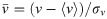
Empirical data for the 2014 and 2018 elections for federal deputies in Brazil, which counted more than 6000 candidates, roughly 140 million voters, and more than 280 million dollars of total investment in each campaign.(A) The standard deviation as a function of the average number of votes per candidate at the state level, for the top four populated Brazilian states, namely, São Paulo (SP, circles), Rio de Janeiro (RJ, squares), Minas Gerais (MG, diamonds), and Bahia (BA, triangles), empty symbols are for 2018, and filled symbols are for 2014. For each state, candidates were grouped by the amount of money that they officially declared to have spent in their campaigns. The dashed line corresponds to a linear behavior. (B) Distribution of rescaled number of votes v¯=(v-〈v〉)/σv for São Paulo (orange circles) and the entire country of Brazil (blue triangles), where 〈v〉 and σv are the average and standard deviation of the number of votes received by the candidates in the same interval (logarithmic binning) of money spent. The black line corresponds to p(v)=exp(-v¯-1), as predicted by Eq (5), if we assume Z(m) = 1/μ. Following the prediction given by Eq (5) from our theoretical approach, the distribution of votes for more than 99% of the candidates follows an exponential distribution. However, it is remarkable that the number of candidates with votes that deviate more than 6σv (highlighted region) from the average is higher than expected, suggesting the existence of outliers.